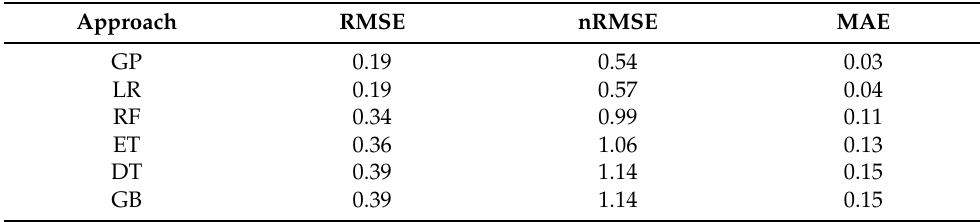
Table 1. Root-mean squared errors (RMSE), normalized root-mean squared errors (nRMSE), mean absolute errors (MAE), and Pearson correlation coefficients R 2 for the individual models regarding the test data between predicted B pred and observed values B Exp for the filtration step.